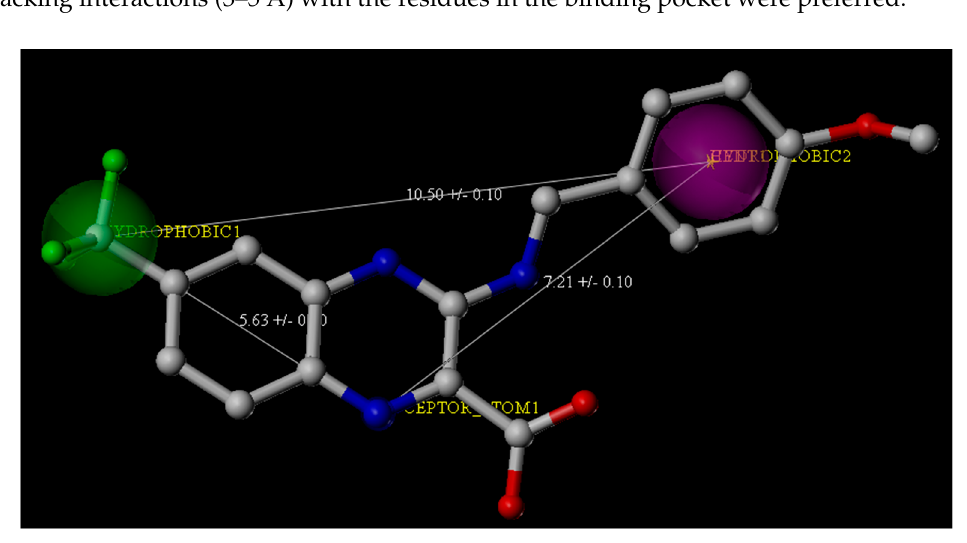
Figure 2. Pharmacophore features derived from the crystal structure of the M. tuberculosis DprE1 complex with Ty38c (the Protein Data Bank Code: 4P8K). Ty38c is shown as the stick structure. Green and purple spheres indicate the hydrophobic groups, and the blue spheres indicate the hydrogen bond donors.